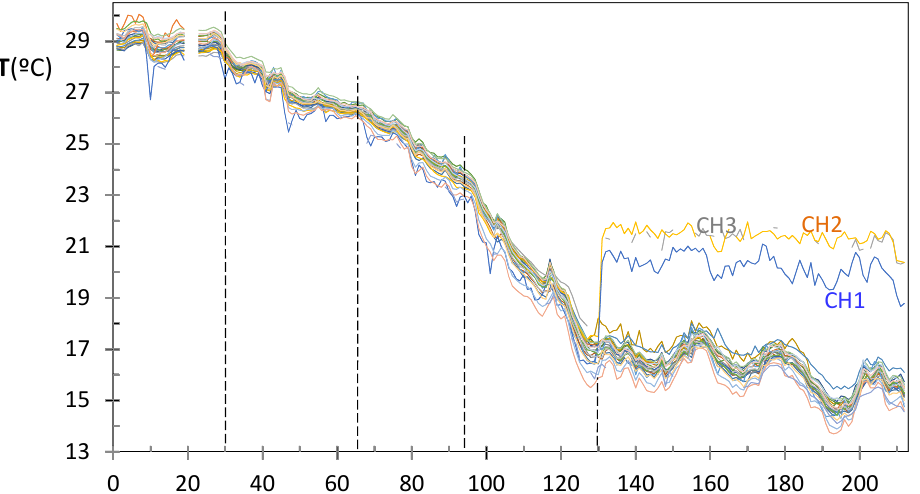
Figure 15. Time series of daily median temperatures for the whole period of 212 days. Vertical dashed lines indicate a change of trend or slope, identified at days 30, 66, 94, and 130.